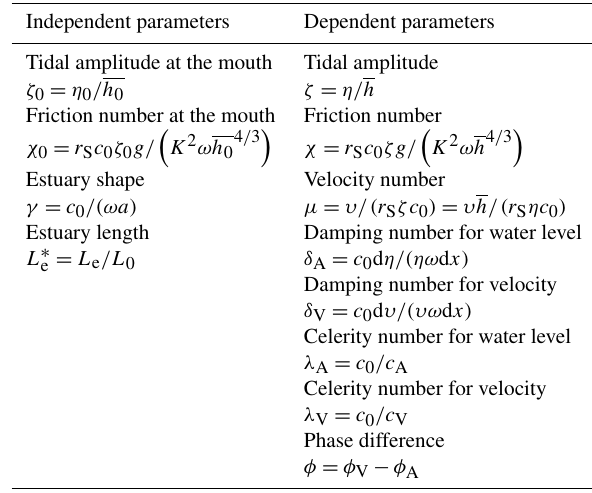
Table 1. Definitions of dimensionless